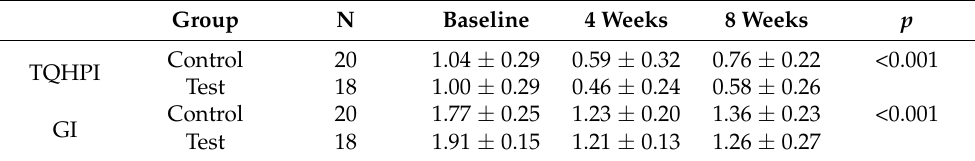
Table 1. Change of PI and GI in CHX solution and CHX gel at the Baseline, 4 weeks and 8 weeks. Mean ± SD.